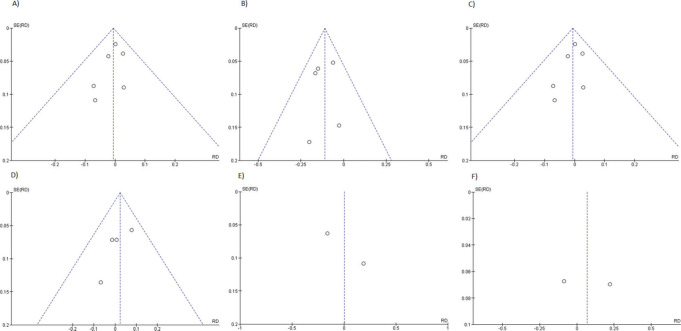
Funnel plots for comparison FK506 plus MMF vs. FK506 alone. A) Graft loss; B) Acute rejection; C) Mortality; D) Infection; E) Adverse events; F) Acute kidney injury. Fixed effect model was used for A, B, and C; Random effect model was used for D and E.